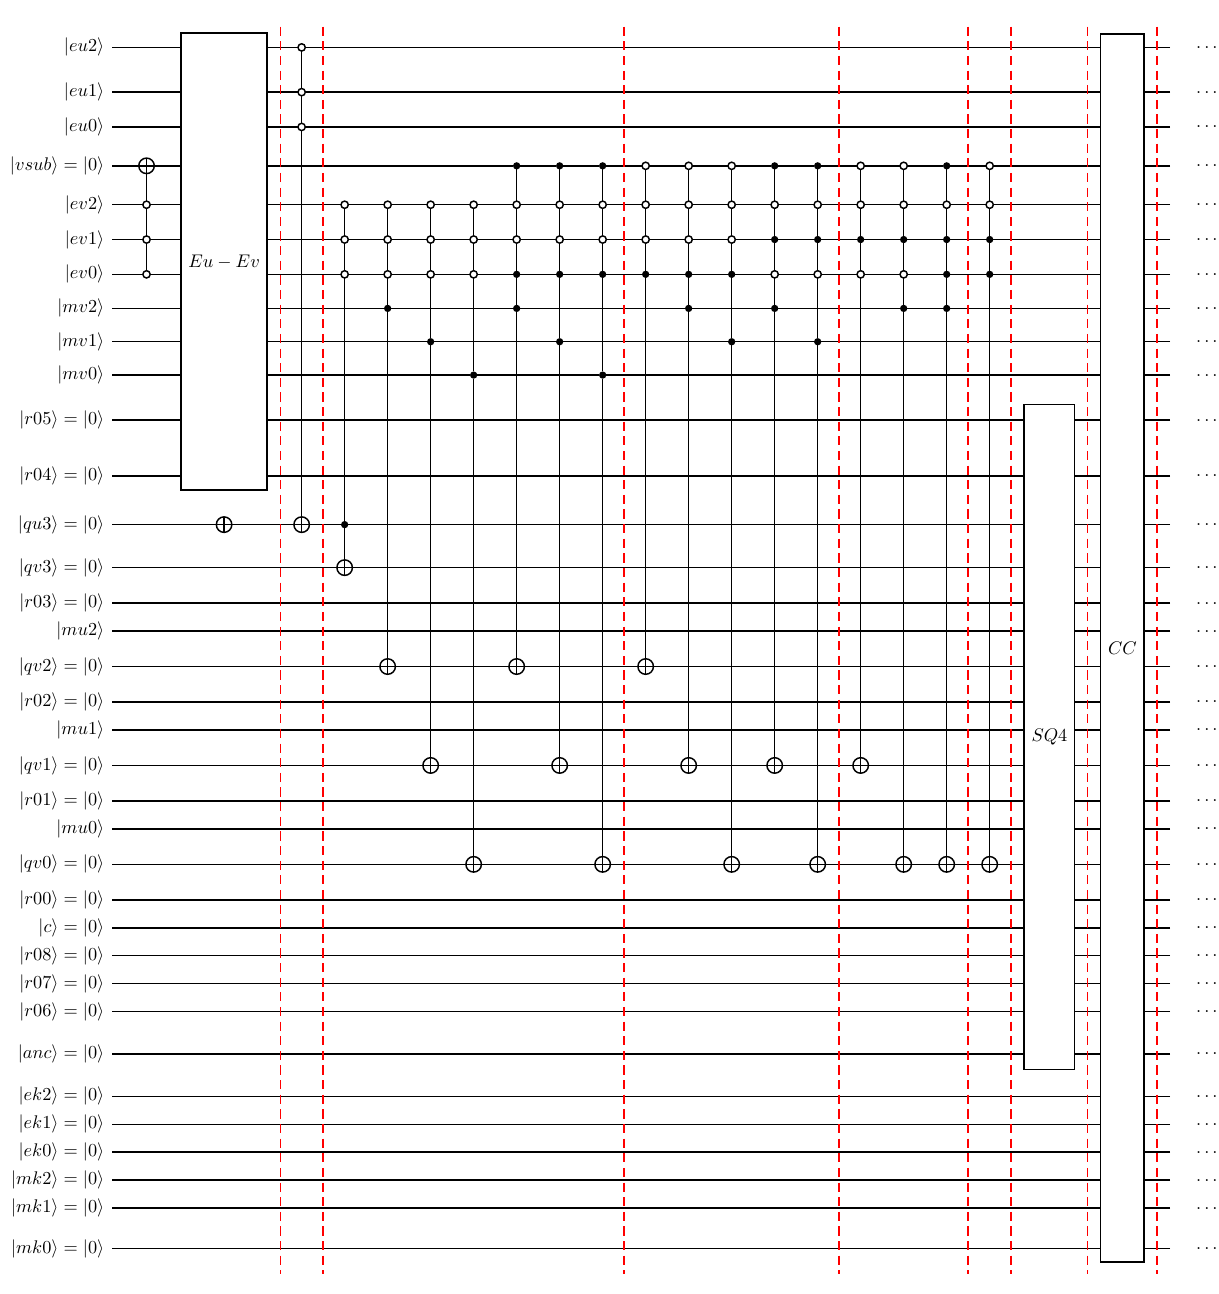
Figure 11. Design EKin2D3 with ( N M + 1 )